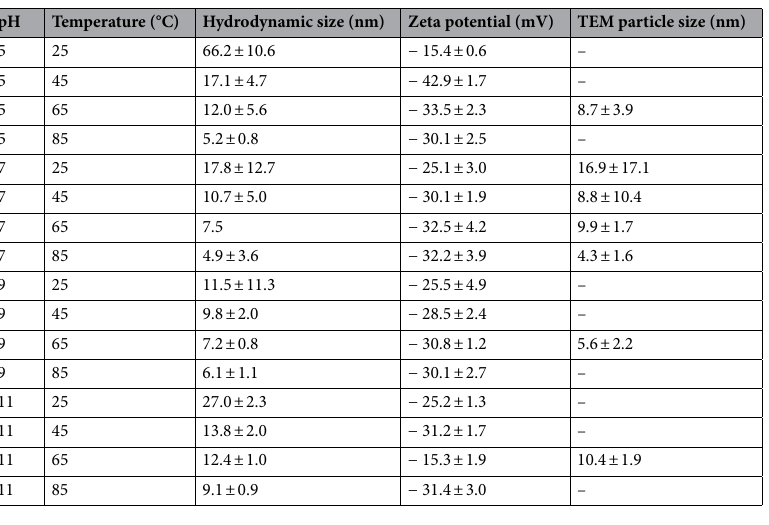
Table 1. Hydrodynamic size, zeta potential, average particle size values for different pH at varying